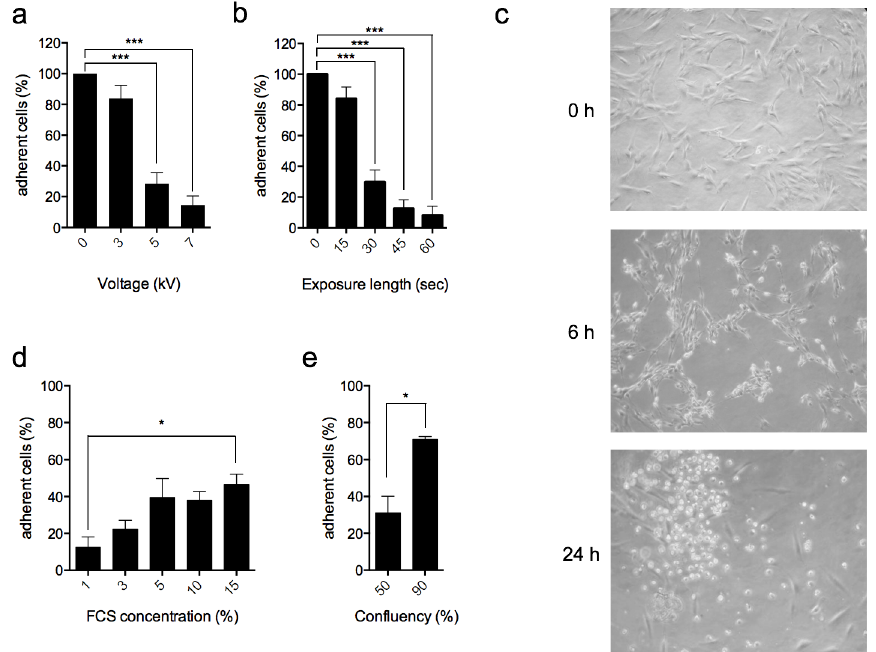
Fig 4. Device settings and cell culture parameters influence cell fate. (a) hPDL were treated with He- GIW using different voltages and (b) exposure lengths. Adherent cell number was evaluated 24h after treatment and expressed as a percentage of control. (c) Cell morphology was monitored by phase contrast microscopy 6h and 24h after treatment. (d) Cell culture incidence on He-GIW treatment was evaluated using different FCS concentrations and (e) cell confluence. Adherent cell number was assayed 24h after treatment and expressed as percentage of control. Error bars represent S.E.M. of three independent experiments p < 0.05 ( * ), p < 0.01 ( ** ) and p < 0.001 ( *** ).